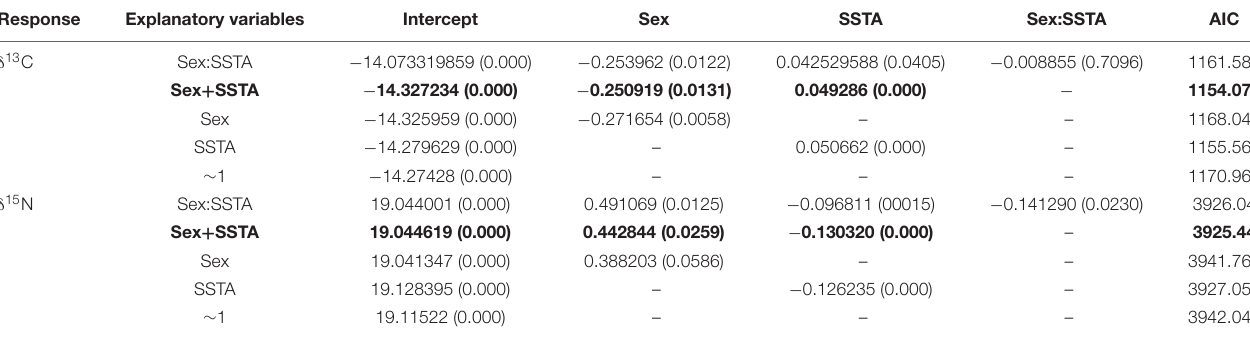
TABLE 2 | Linear mixed models for δ 13 C and δ 15 N vibrissae values and sex, SSTA and their interactions as fixed effects.